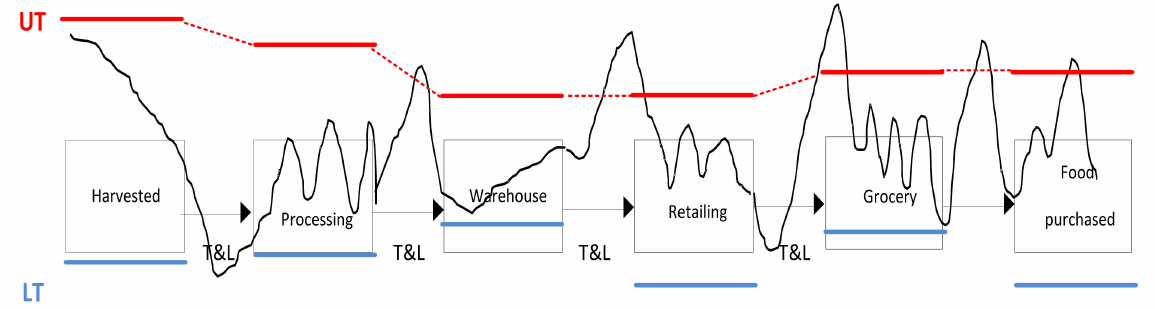
Figure 4. Exemplary lower/upper temperature limit line at different FCC stages. Typical profile of temperature changes in the FFC from rural production to consumer table. Source: based on Mercier et al. (2017) [58]. Abbreviations: UT—upper temperature, LT—lower tolerance temperature, T&L—transport and logistics.